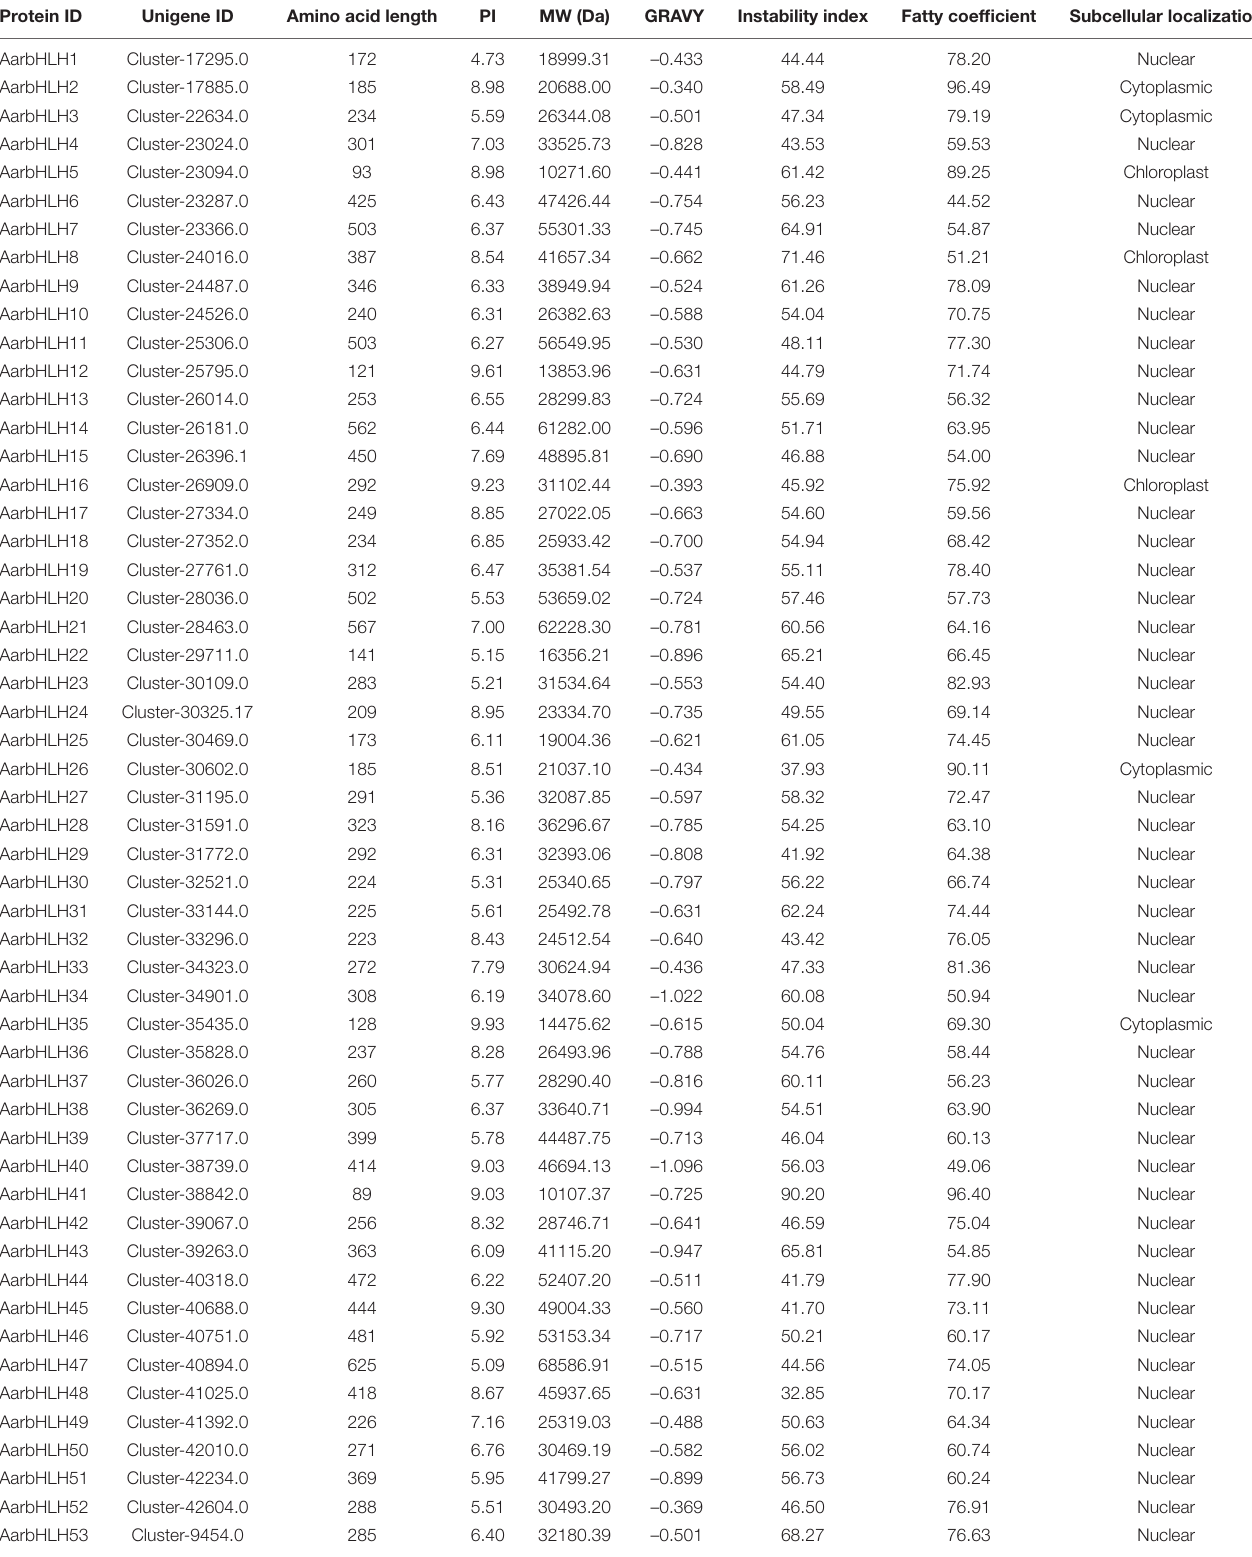
TABLE 1 | The complete list of AarbHLH proteins and their physiochemical